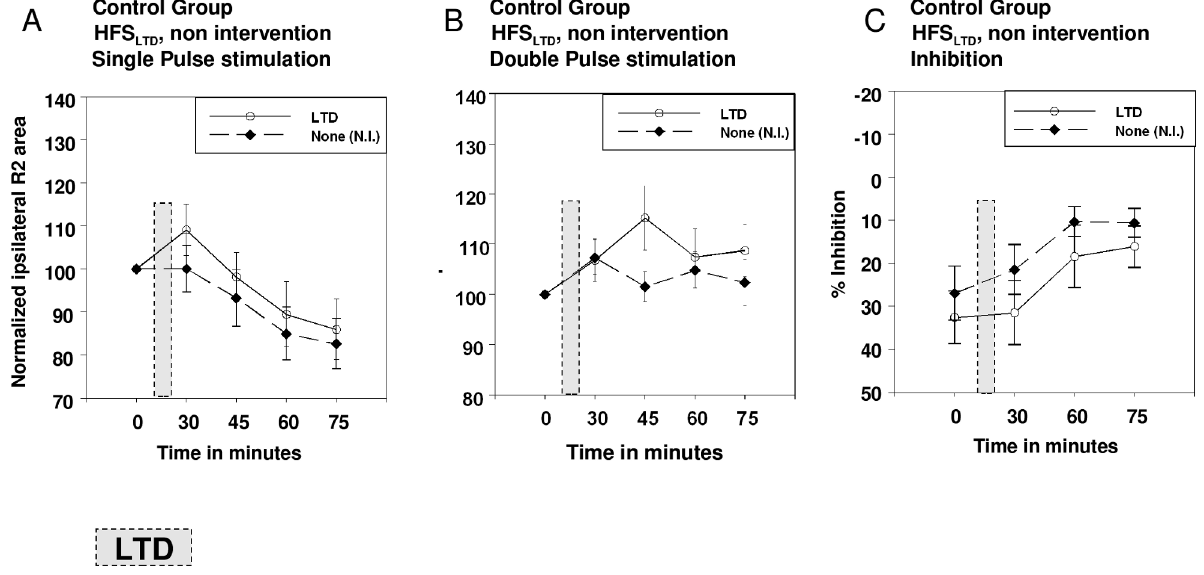
Figure 5. Presentation of normalized data for HFS LTD and HFS non-intervention protocols in controls. Panel A presents the results after single pulse, panel B after paired-pulse stimulation, and panel C % inhibition (higher values indicate stronger inhibition). R2 area under the curve is given in m V/sec. Mean and standard errors are shown. Circles indicate the HFS LTD , black diamonds the non-intervention protocol.